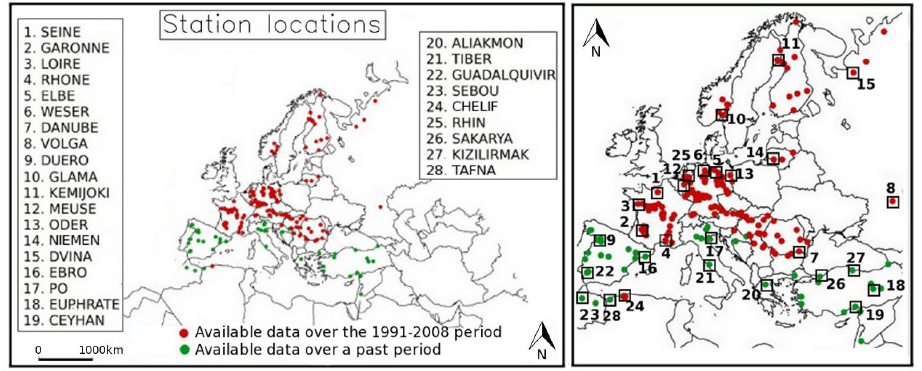
Fig. 2. (Left) overview of the available GRDC station locations over the considered area, for the 1991–2008 period in the CNF area and for a past period in the MBS area (red and green dots, respectively); and (right) the stations for which the river discharge is presented in Figs. 7 and